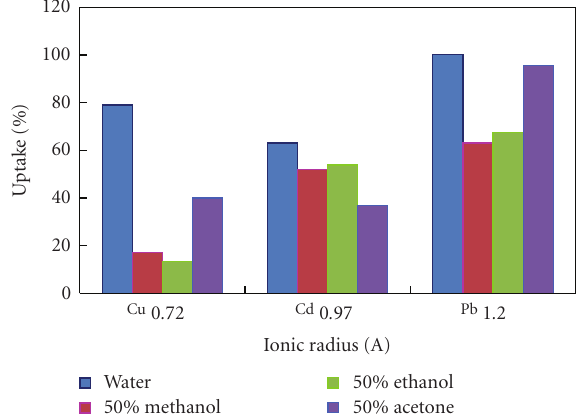
Figure 2: The e ff ect of ionic radii on the percentage uptake in di ff erent